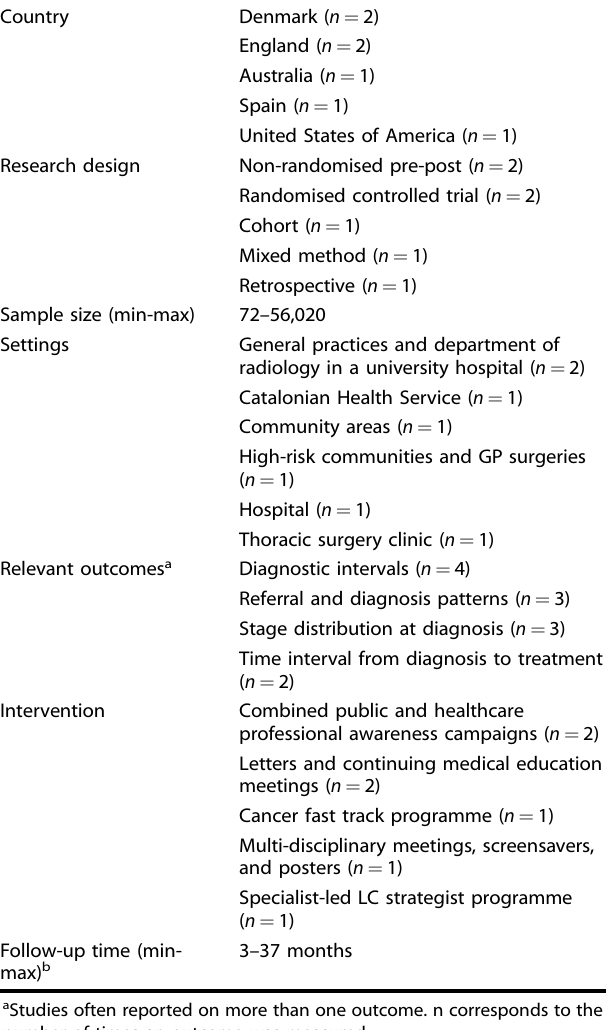
Table 1. Study characteristics ( n =